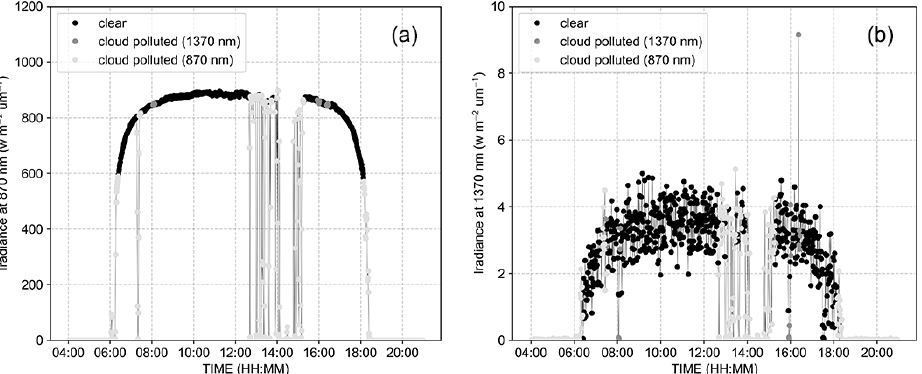
Figure 2. Direct normal irradiance measurements of EKO instruments at 870nm (a) and 1370nm (b) on 8 September 2020 at the IAP. Cloudy parts and very small measurements are shown in gray, light gray, and dark gray and are filtered out using 870 and 1370nm measurements, respectively. Clear-sky parts are shown in black.